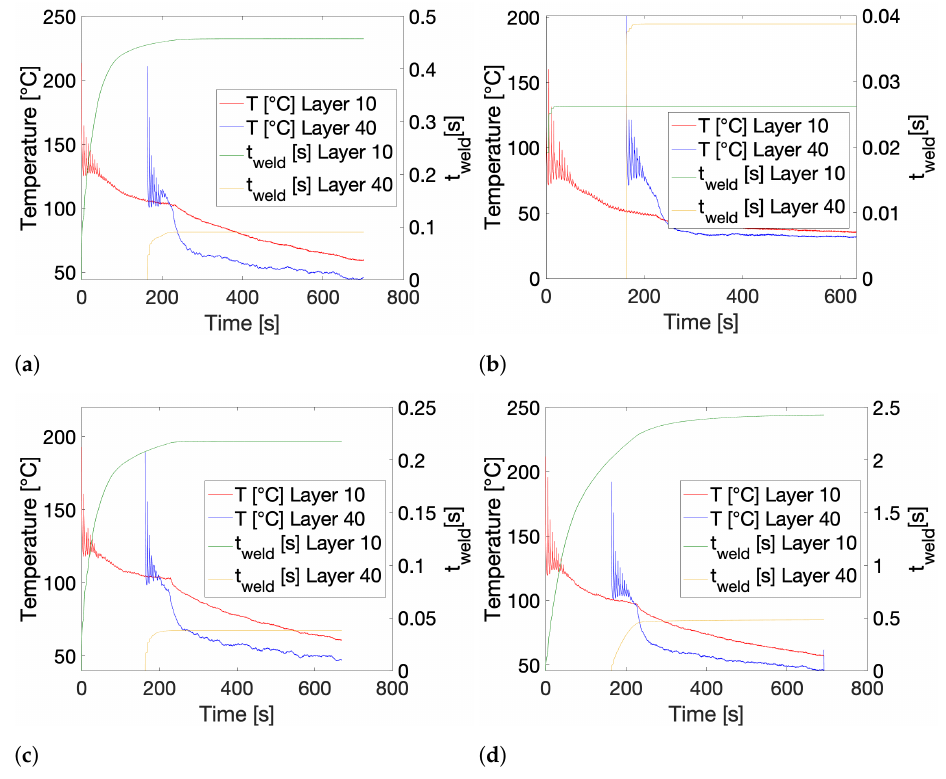
Figure 9. The cumulative progression of the calculated isothermal weld time versus the correspond- ing thermal history. ( a ) Condition 1: HMWPA, T liquefier = 260 °C, v print = 11 mm/s and T build plate = 110 °C. ( b ) Condition 2: HMWPA, T liquefier = 260 °C, v print = 11 mm/s and T build plate = 40 °C. ( c ) Condition 5: HMWPA, T liquefier = 220 °C, v print = 11 mm/s and T build plate = 110 °C. ( d ) Condition 6: LMWPA, T liquefier = 240 °C, v print = 11 mm/s and T build plate = 110